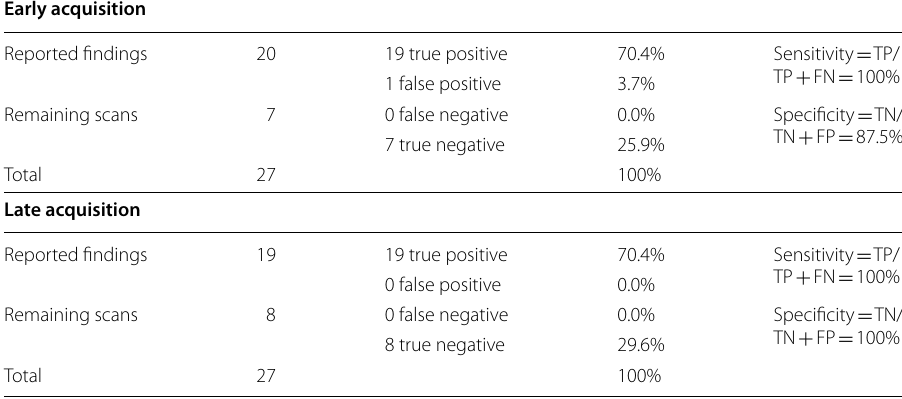
Table 2 Summary of scan distribution